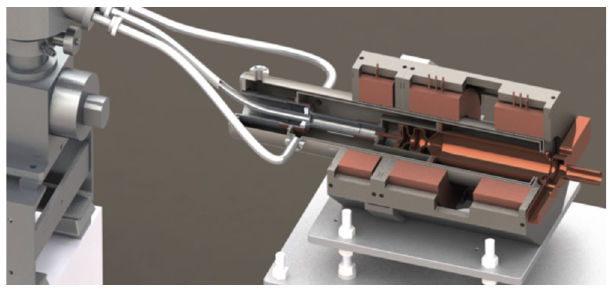
FIG. 1. Cryogenic, very high field S-band photoinjector, with 1.45 cell Cu gun structure (center) externally coupled to wave- guide through a mode-launcher scheme (far right). Also shown: cryostat envelope and liquid neon-based cryocooler (far left), mounting equipment, emittance compensation solenoid (surrounding rf